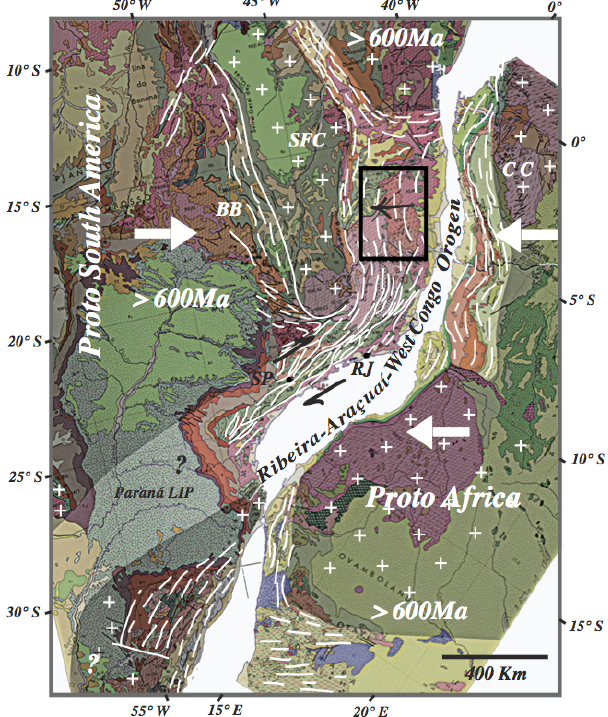
Figure 1. Schematic reconstitution of the position of South Amer- ica and Africa before the opening of the South Atlantic (Vauchez et al., 2007). Shaded areas represent domains where collision oc- curred before ∼ 600Ma (white crosses: cratonic domains; white lines: Neoproterozoic belts). The area delimited by the rectangle represents the location of Fig. 2. Arrows show the convergence be- tween South America and Africa. Small black arrows show the main kinematics. CC: Congo craton; BB: Brasilia belt; SP: São Paulo; RJ: Rio de